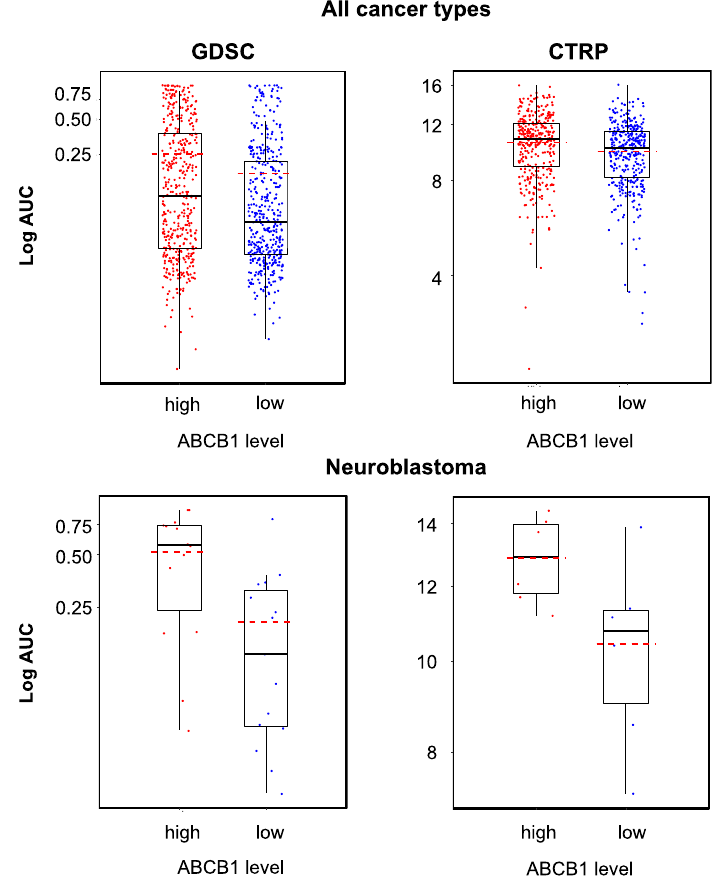
Figure 5. YM155 sensitivity in cancer cell lines characterized by high or low ABCB1 expression based on the analysis of GDSC and CTRP data, both determined across all investigated cancer types / cell lines (GDSC, p < 0.001; CTRP, p < 0.001) and in a neuroblastoma-specific analysis (GDSC, p = 0.006; CTRP, p = 0.04). High ABCB1 expression was associated with decreased YM155 sensitivity, but the YM155 sensitivity of individual cell lines could not be predicted based on the ABCB1 levels.